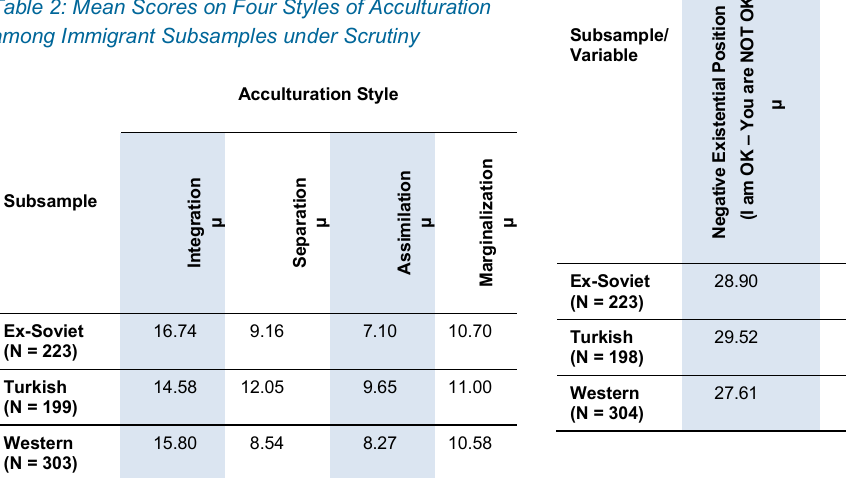
Table 2: Mean Scores on Four Styles of Acculturation